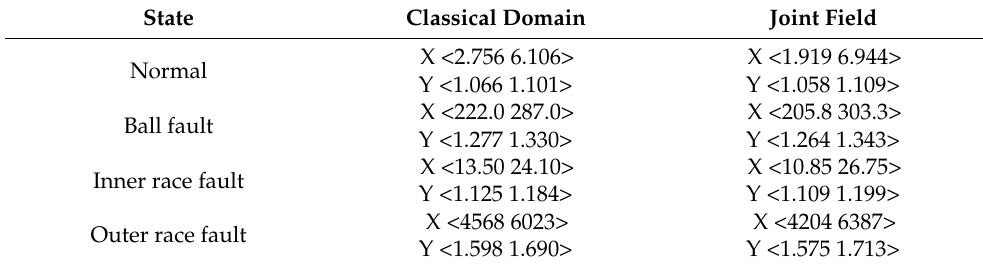
Table 6. Classical Domain and Joint Field When SPOF Diameter = 0.007 in, HP = 2.